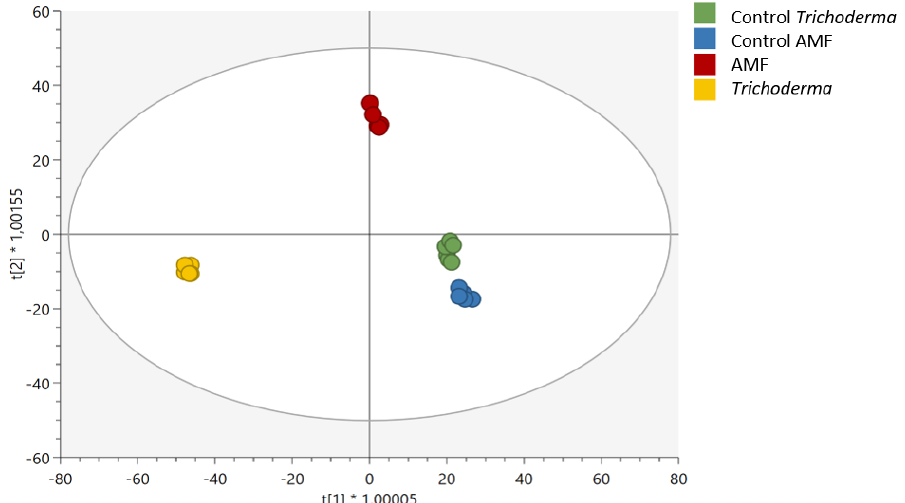
Figure 2. Score plot in the first ( x -axis) and second ( y -axis) latent vector of orthogonal projection to latent structures discriminant analysis (OPLS-DA) supervised modeling carried out on metabolomic profiles of tomato leaves after treatment with Trichoderma, AMF, and control samples (R 2 Y = 0.8, Q 2 Y =